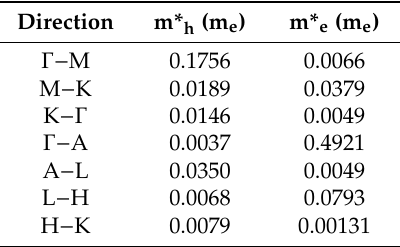
Figure 2. ( a ) Electronic band structure and ( b ) projected electronic density of states (PDOS) of hexagonal β -CuSCN. Table 2. Predicted e ff ective masses of holes (m* h ) and electrons (m* e ) of β -CuSCN along high symmetry